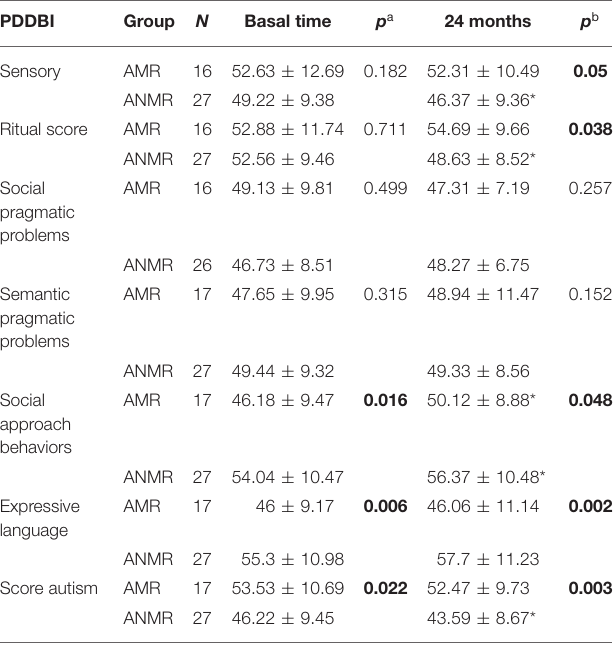
Analysis of the Pervasive Developmental Disorders Behavior Inventory test regarding the neurodevelopmental regression and non-neurodevelopmental regression groups at baseline and after follow-up at 24 months. MentalRegression(AMR).WithoutMentalRegression(ANMR).Thedataareexpressedas means ± DS. Mixed-Designs ANOVA with Sidak correction used to compare differences among groups. P < 0.05 value in bold, was considered for significant results. p a . p